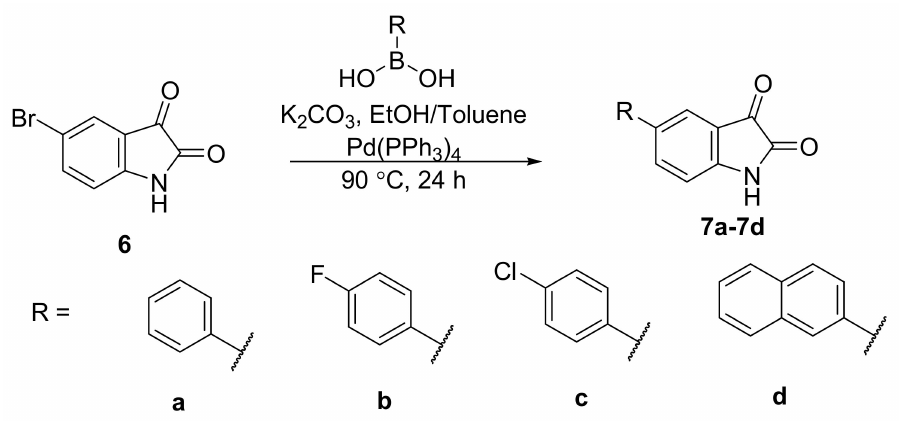
Scheme 1. Synthesis of 5-arylisatins 7a–7d